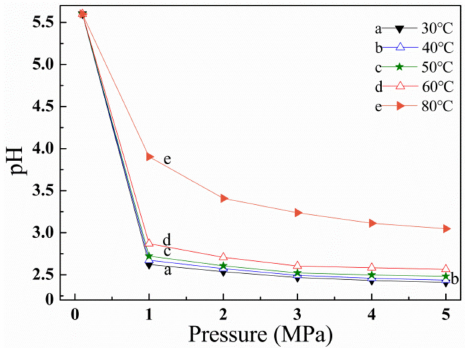
Figure 8. The pH curves of the formation solution at different temperatures and pressures.